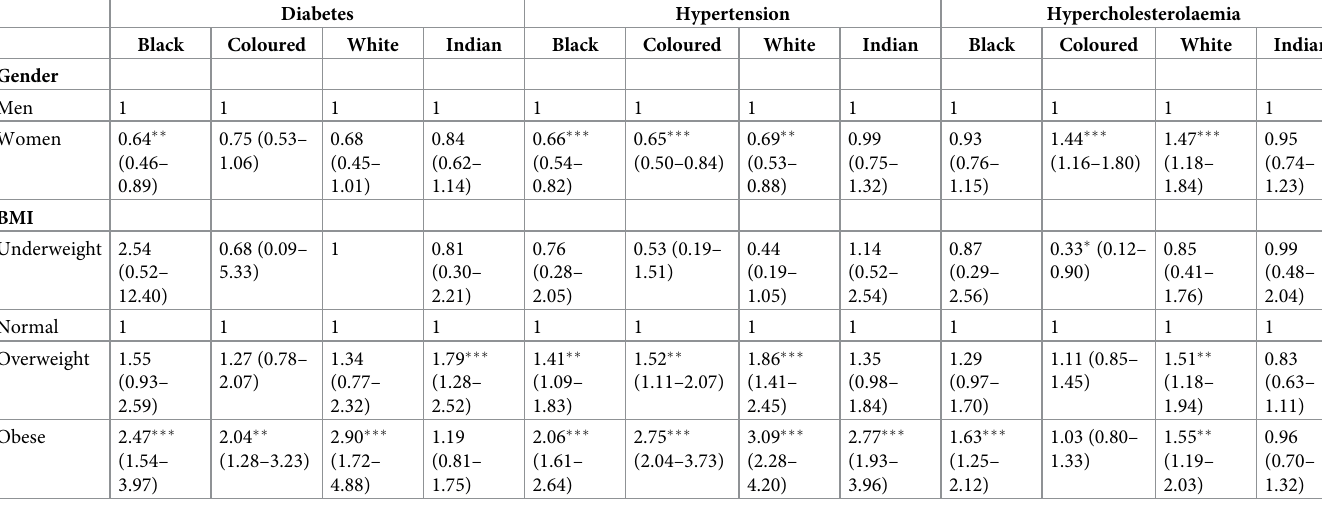
Table 4. Adjusted logistic regression models for association of diabetes, hypertension and hypercholesterolaemia with gender and BMI by population